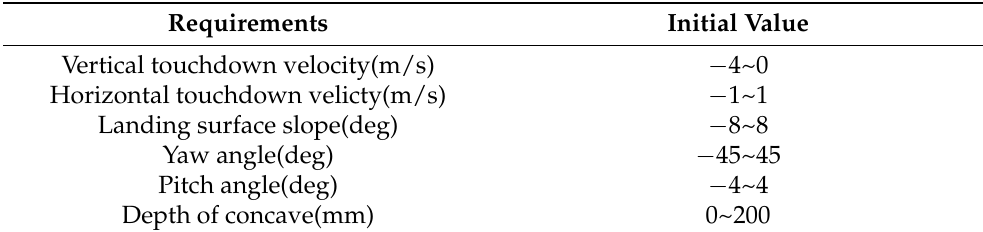
Table 5. Initial landing conditions.